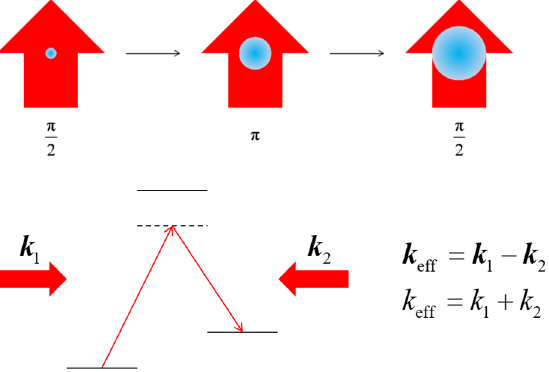
Figure 1. Schematic illustration of the basic process underlying the conventional PSI. The blue circle is the atom cloud and the red arrows are the Raman pulses. A temporal sequence of Raman pulses is applied during the expansion of the atom cloud ( top ), and each Raman pulse is a pair of counter-propagating light beams that drive a two-photon transition ( bottom ).